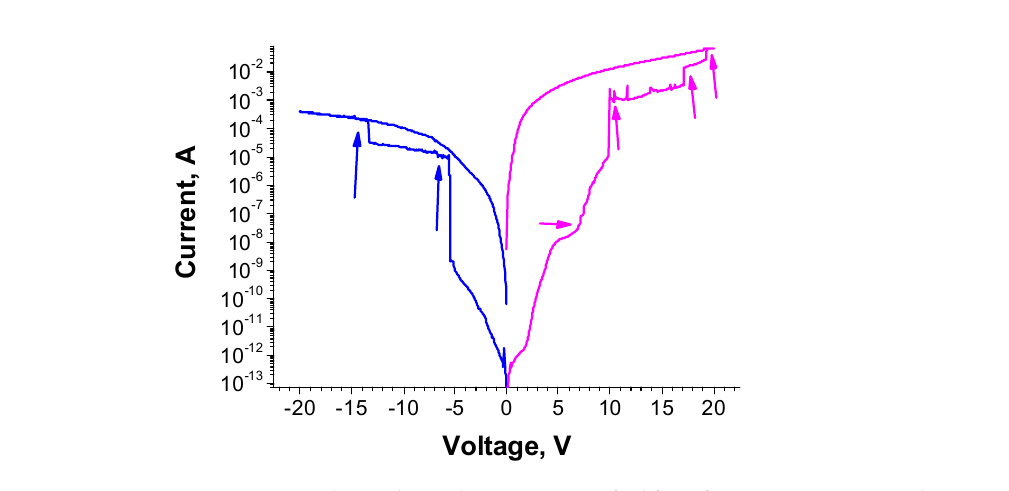
Figure 2. Typical switching characteristics of Al/GO/n-Si MIS structures showing multiple sharp transitions from HRS to LRS.